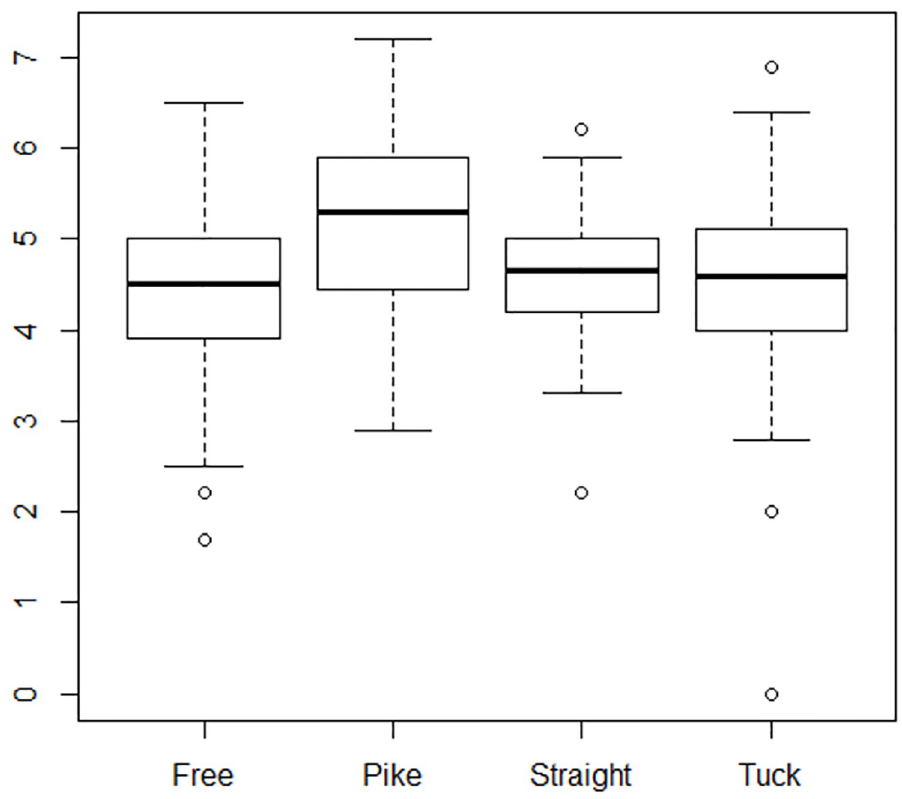
Fig 4. Distribution of mean scores for diving positions. Box plots showing the distribution of mean scores for all four possible dive positions: free, pike, straight, and tuck.